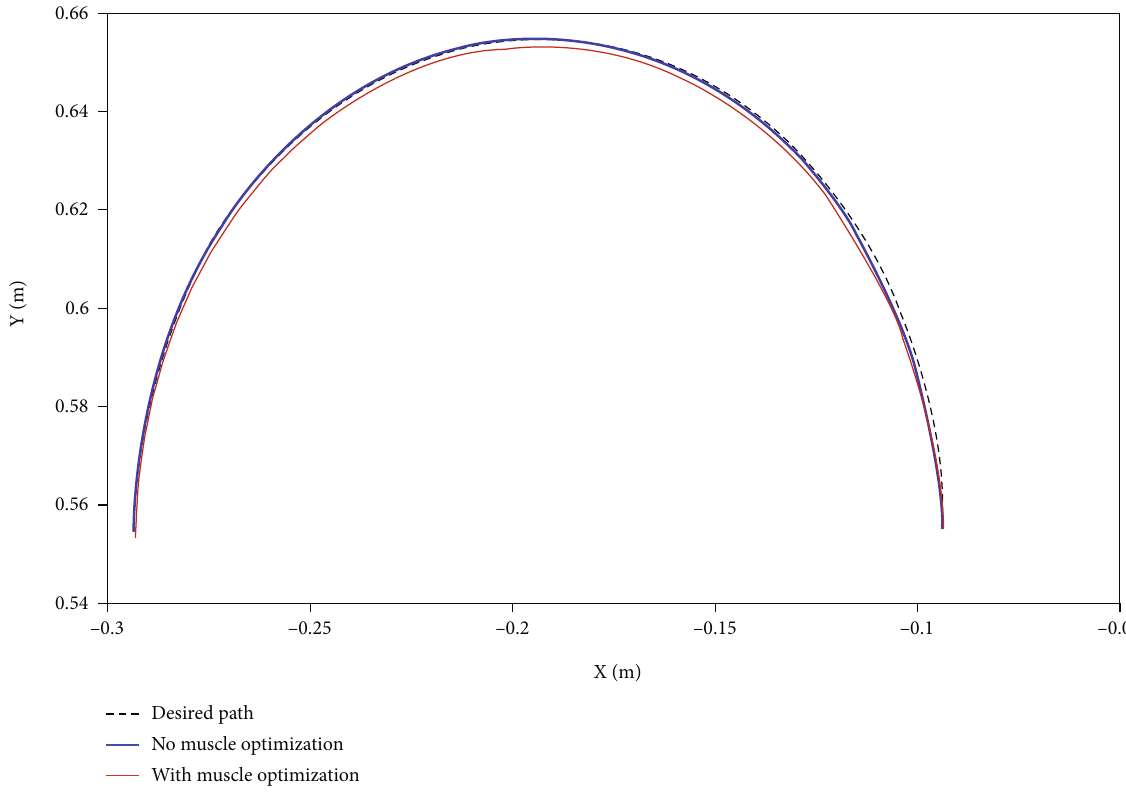
Figure 4: The moving trajectory of the model with/without optimizing the muscular